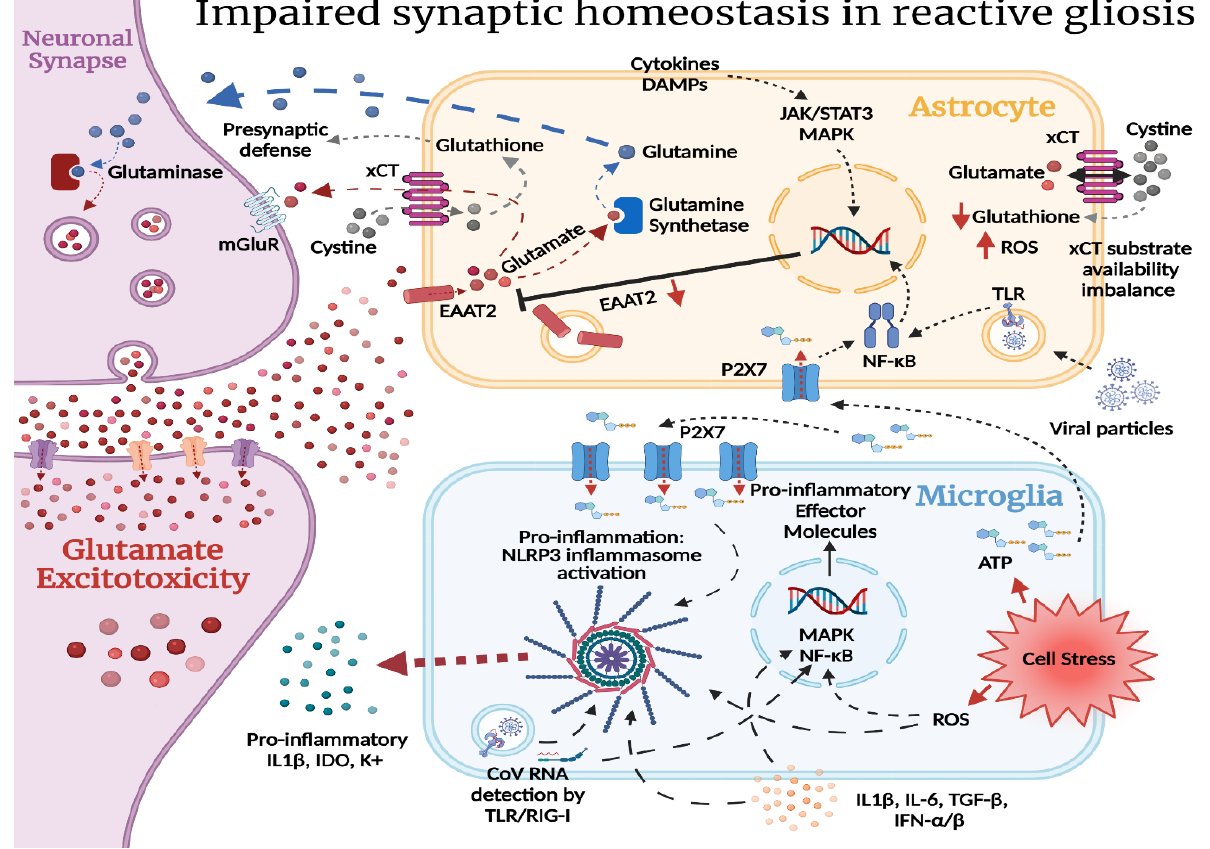
Figure 3. Glial activation and excitotoxicity following COVID-19 illness: In glutamatergic synapses, glutamate is transported into astrocytes by the EAAT2 transporter. It can be transported back to the pre-synapse in the form of glutamine, after being converted by the astrocytic glutamine synthetase. Glutaminase in the pre-synapse converts glutamine into glutamate for vesicular storage [55].